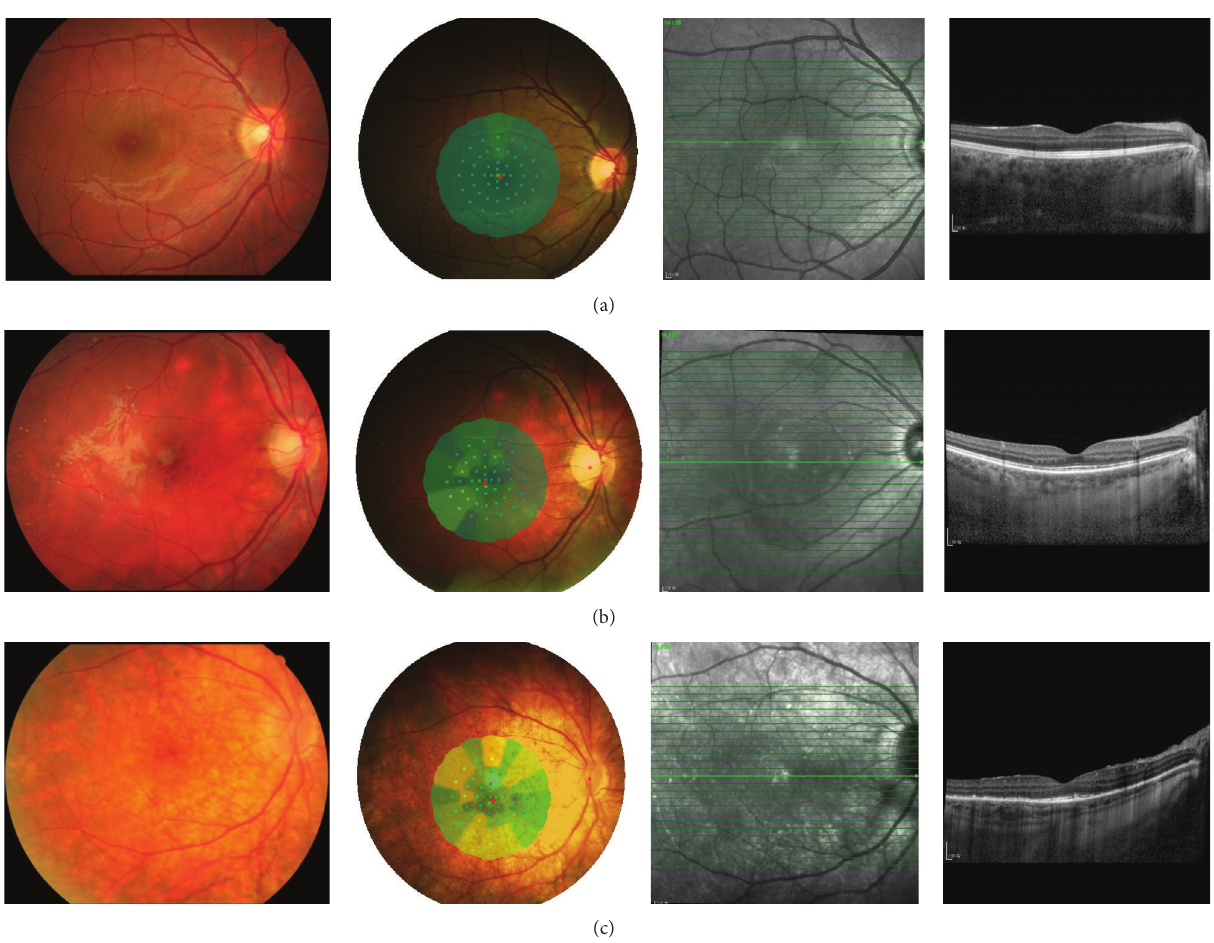
Figure 2: Fundus appearance, microperimetry, and OCT findings in different groups (12 months after disease onset). (a) (COST+/IS/OS+): a rathernormalfundus;meanretinalsensitivity19.50 dB;OCTimagedemonstratedintactCOSTandjunctionbetweenthephotoreceptorinner and outer segment (IS/OS) lines. (b) (COST − /IS/OS+): a “sunset glow” fundus; mean retinal sensitivity 18.00 dB; OCT shows fragmented COST line and intact IS/OS line. (c) (COST − /IS/OS − ): severe sunset glow fundus with hyperpigmentation; mean retinal sensitivity 15.80 dB; OCT demonstrated absent COST line and fragmented IS/OS line with thickened RPE